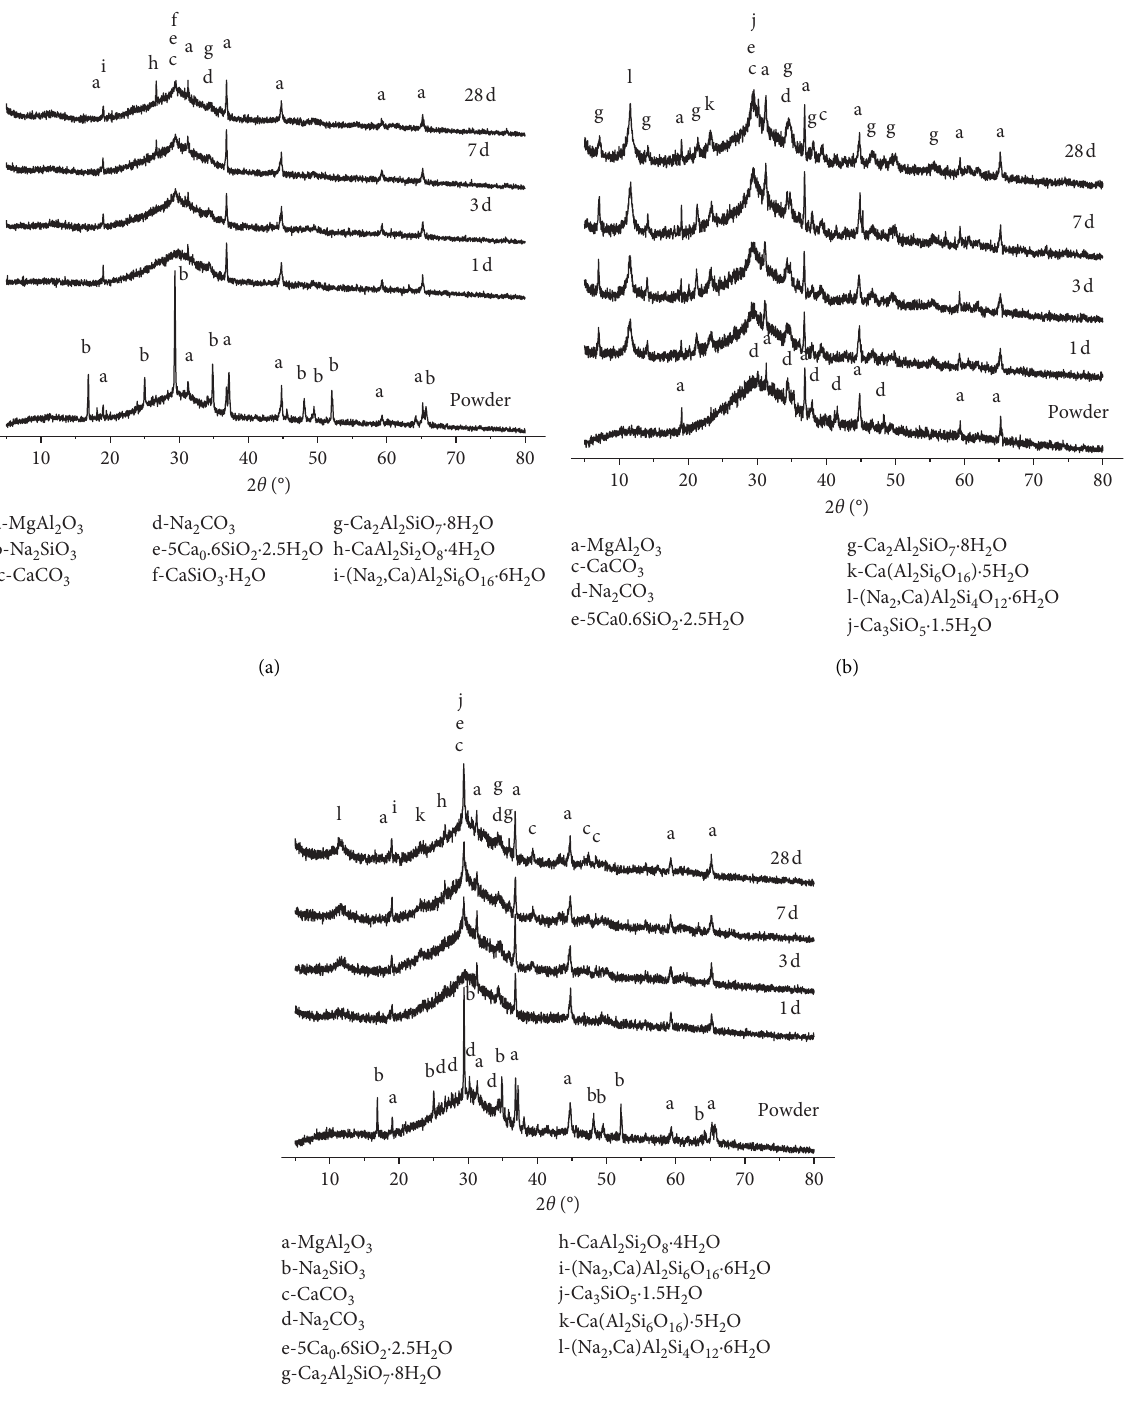
Figure 13: XRD spectra of reaction products of alkali-activated nickel slags at various ages when the Na (a) NS13-N2-J1. (b) NH8.52. (c)